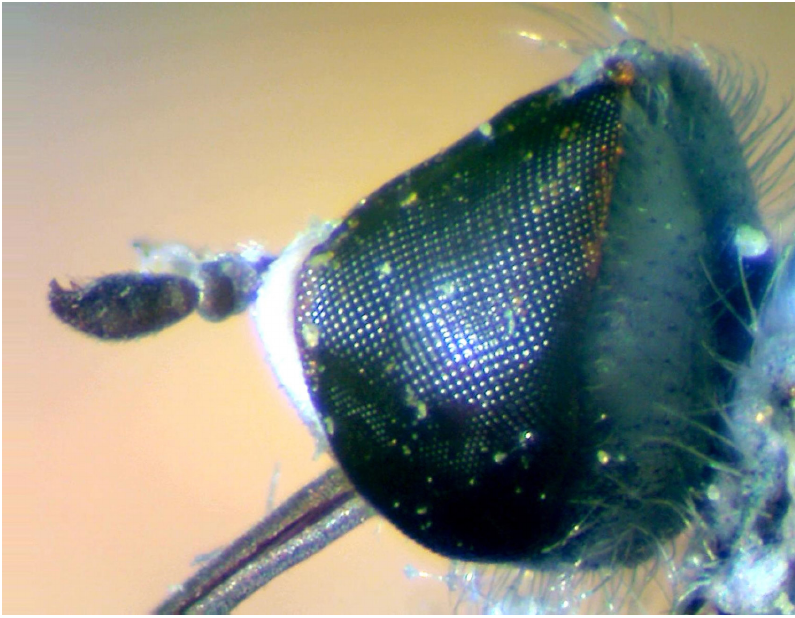
Fig. 13. Protypusia dimonica (Zaitzev, 1996) gen. et comb. nov., ♂.